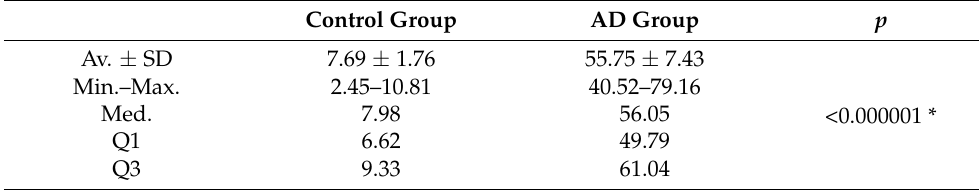
Table 2. UCHL1 concentration [ng/mL] in the AD group compared to the control group.